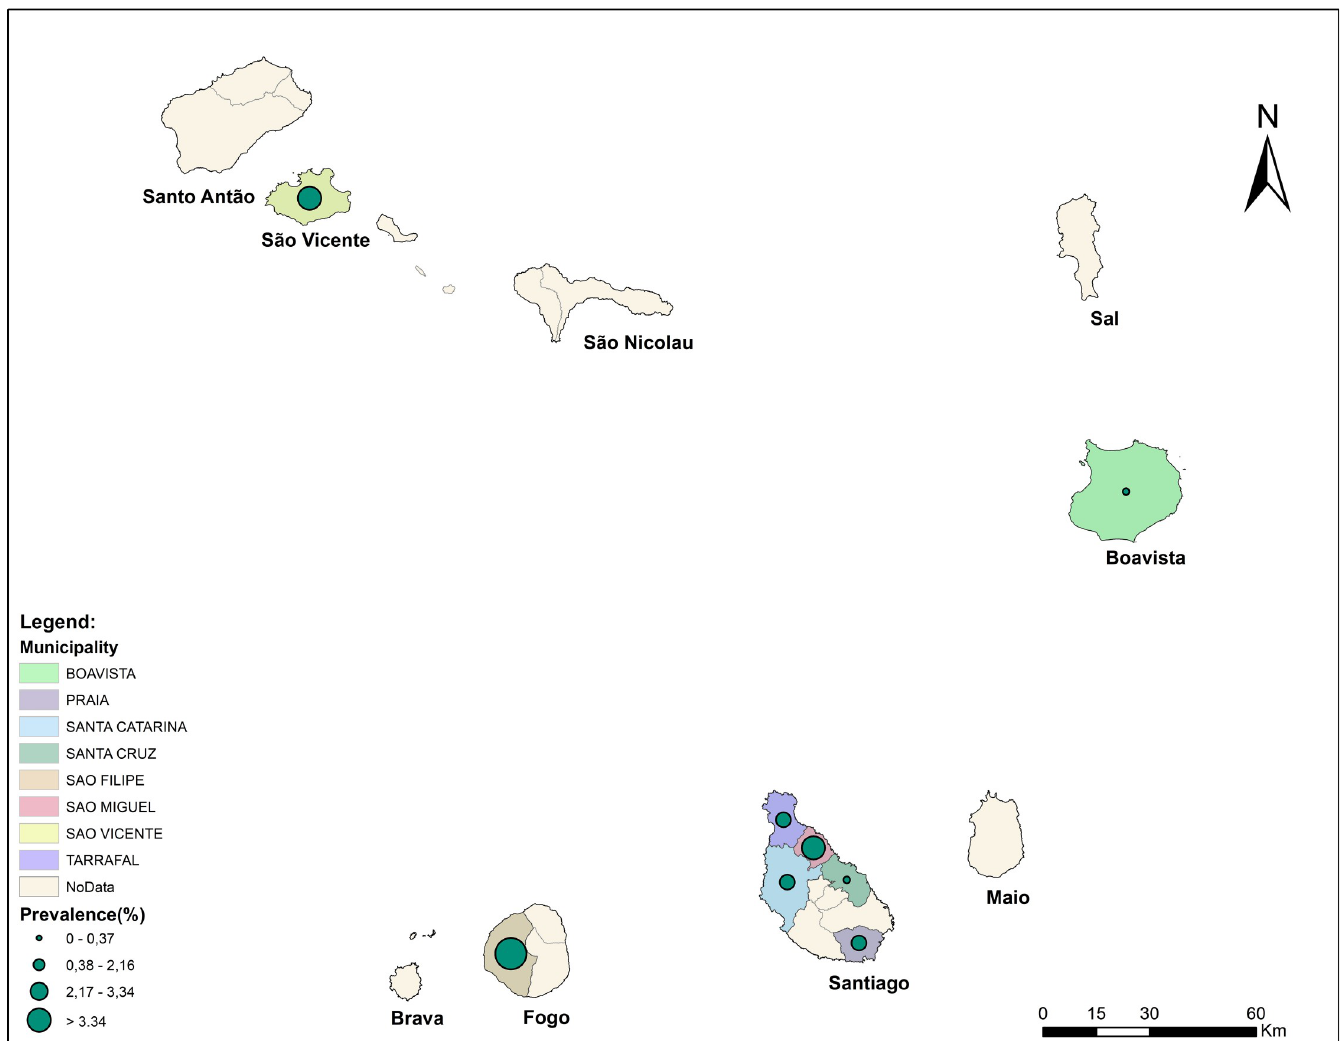
Fig 2. Prevalence of the G6PDd among the Cape Verdean population by municipalities.